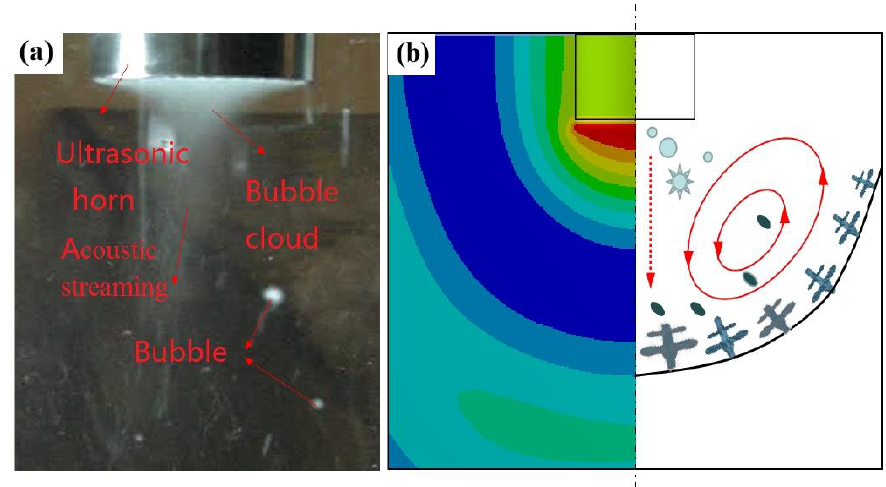
Figure 12. ( a ) Diagram of ultrasonic vibration in water, ( b ) mechanism diagram of ultrasonic acting on the solidification process.